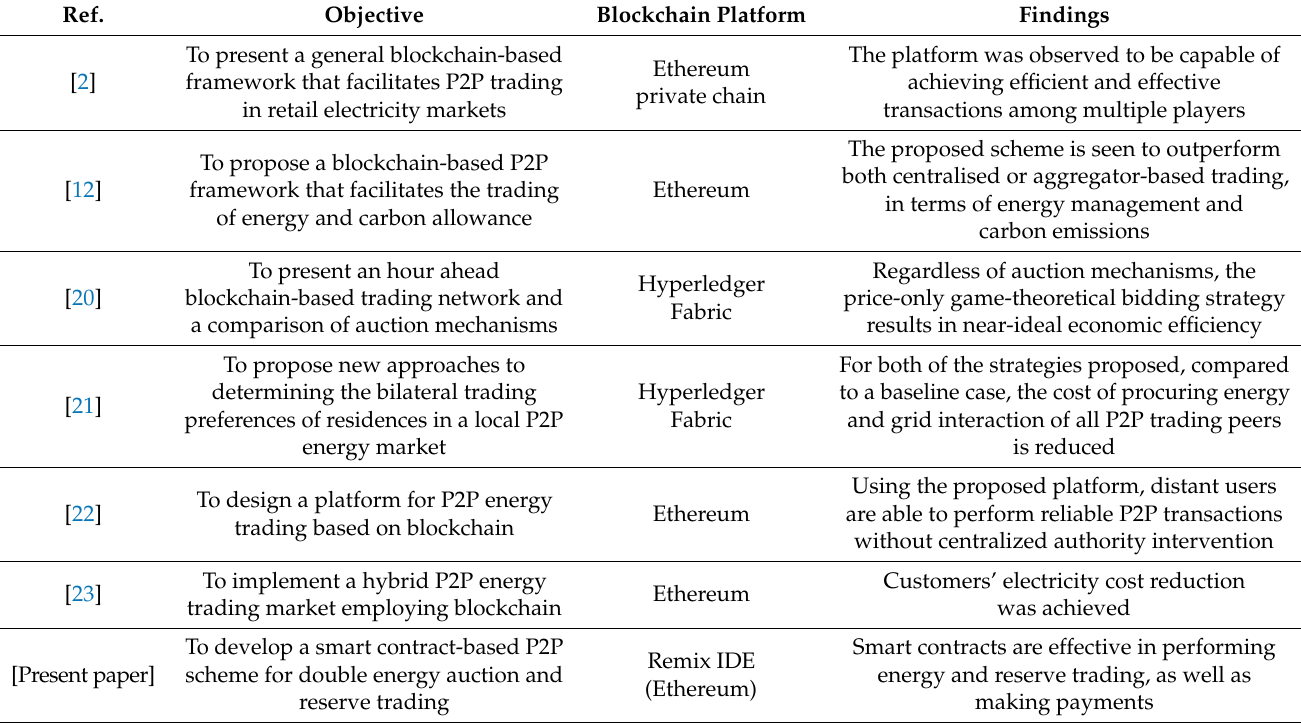
Table 1. Objectives, blockchain networks and findings of selected